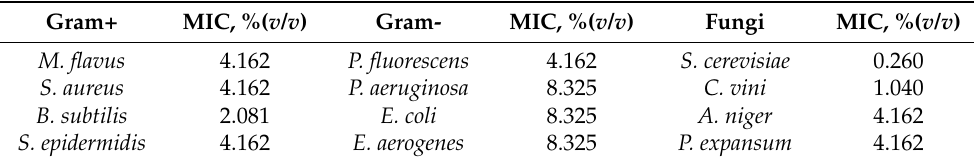
Table 3. Minimal inhibitory concentrations of ethanol extract of O. pseudoglandulosa determined with microdilution